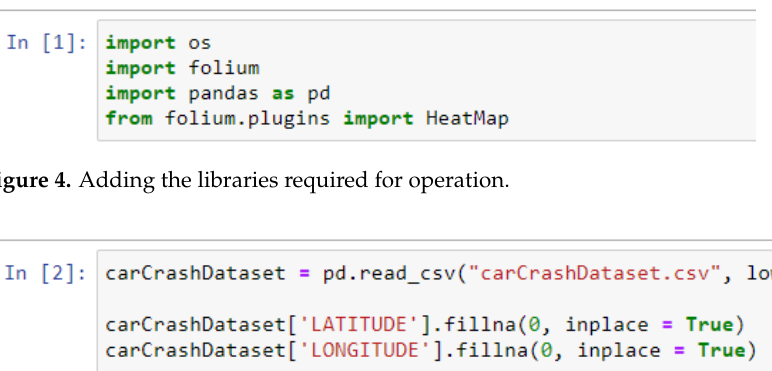
Figure 4. Adding the libraries required for operation. Figure 5. Adding the dataset and initial value processing. Figure 5. Adding the dataset and initial value processing.